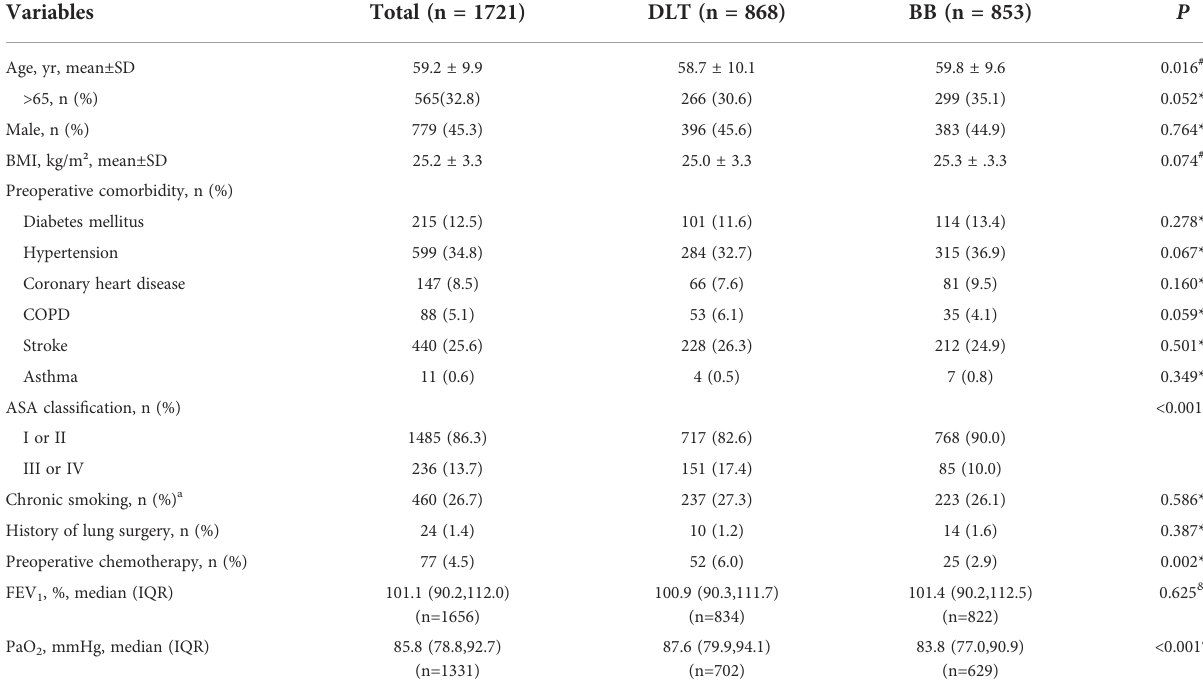
TABLE 1 Baseline and preoperative